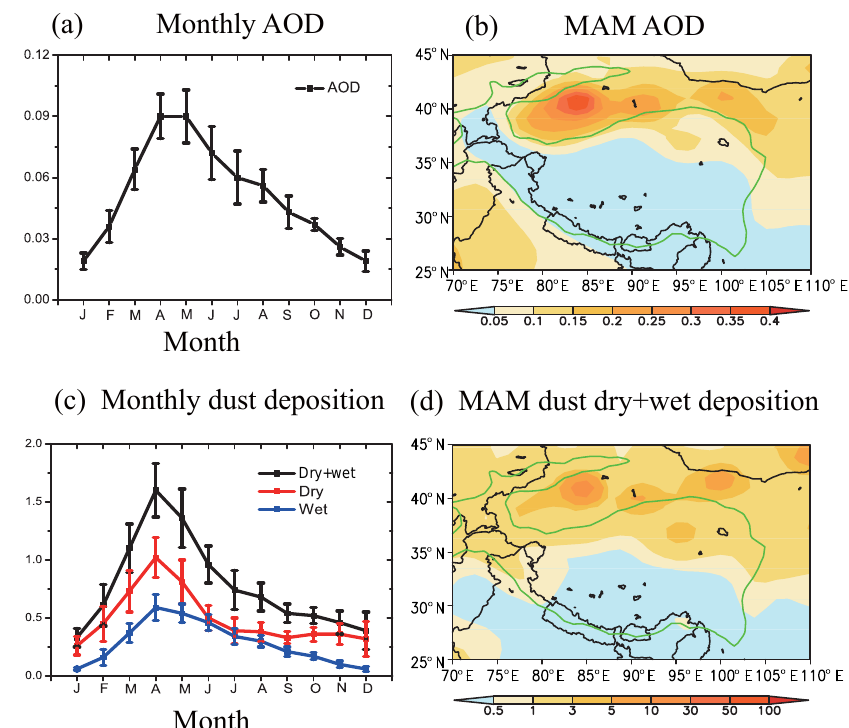
Figure 2. (a) Monthly dust AOD and (b) spatial distribution of the March–April–May (MAM) averaged AOD from the CAM4-BAM model over the Tibetan Plateau (70–110 ◦ E and 25–45 ◦ N). (c) Monthly dust deposition (µgm − 2 s − 1 ) including dust dry, wet and dry+wet deposition and (d) spatial distribution of the MAM averaged total dust deposition (dry + wet, µgm − 2 s − 1 ) over this region. Note that the error bars (a, c) represent the standard deviation of the corresponding variables, and the green outlined area (b, d) indicates the plateau above